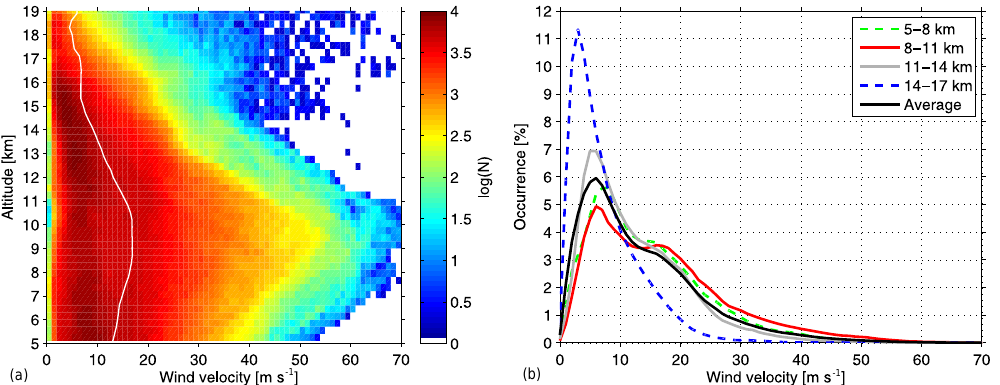
Figure 2. A climatology of horizontal wind velocities obtained by MAARSY. (a) Number densities of horizontal wind velocity in logarithmic scale and the white line indicates the mean profile of wind velocities along the altitudes; (b) distributions of wind velocity grouped into four height gates for every ∼ 3km from ∼ 5 to